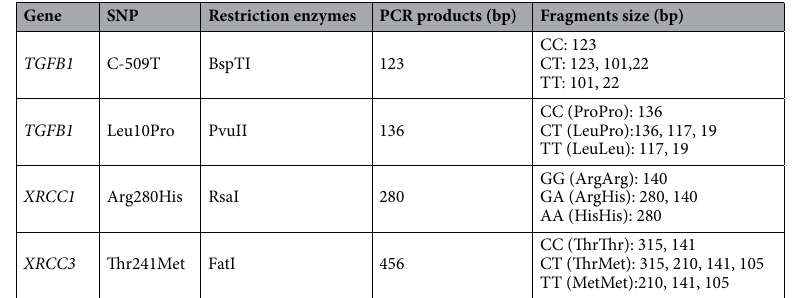
Table 8. The length of PCR products, restriction enzymes and fragments.